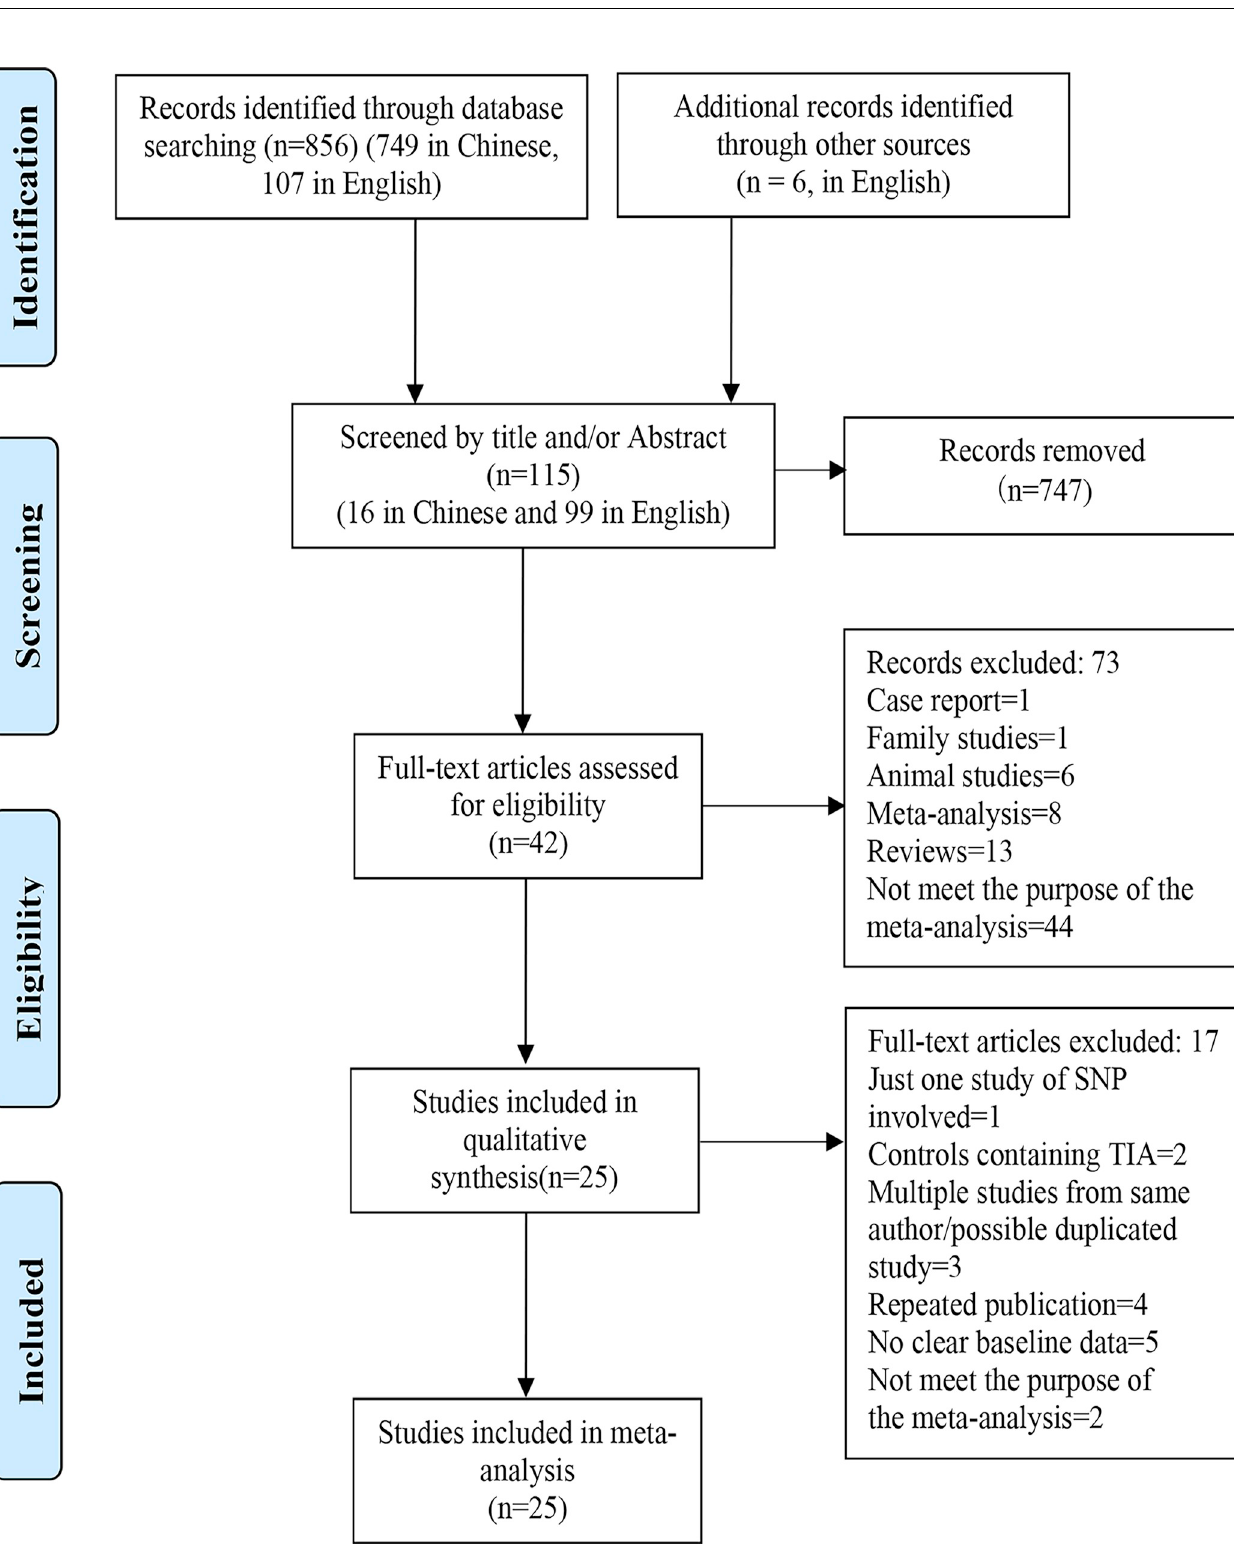
PLOS ONE | https://doi.org/10.1371/journal.pone.0263459 June 2,